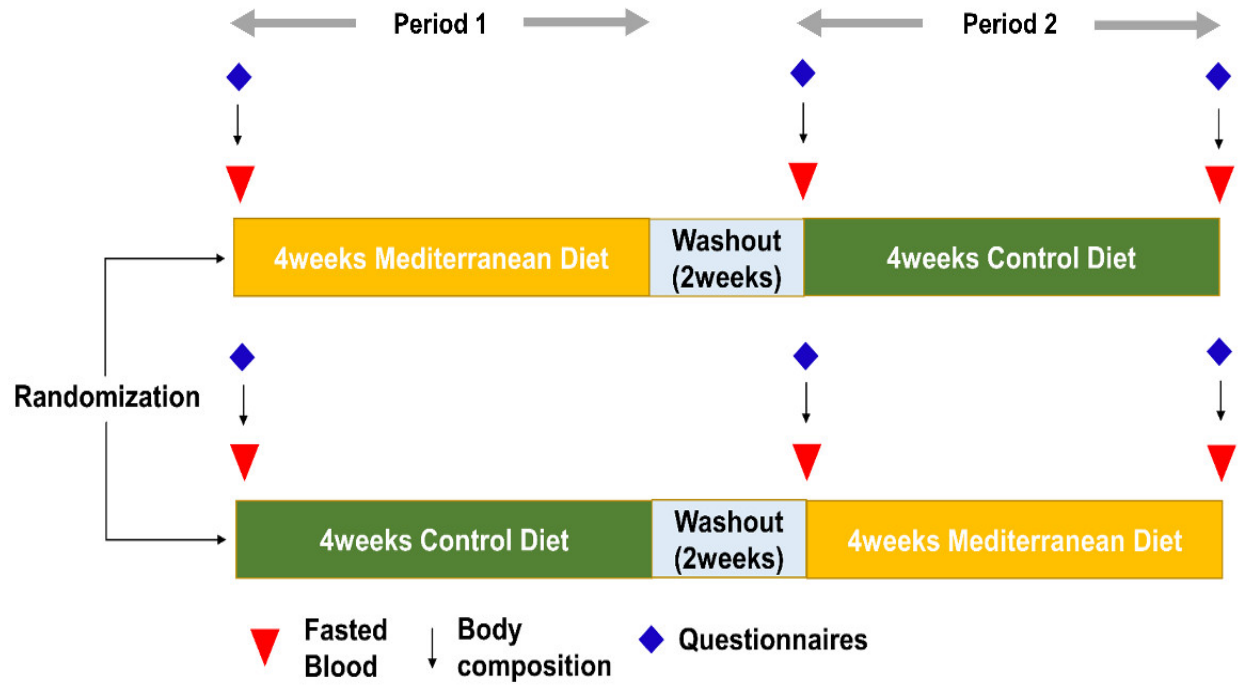
Figure 2. Scheme of